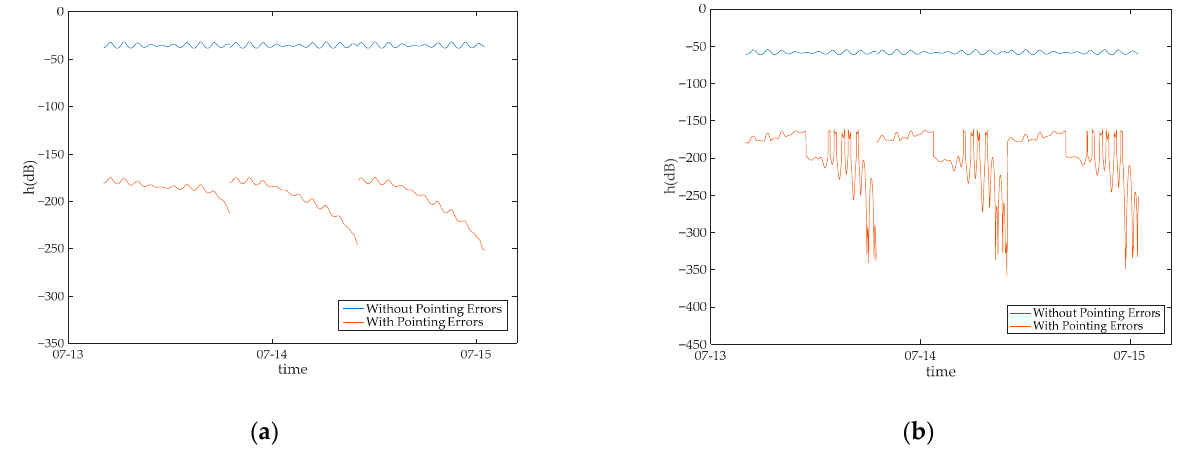
Figure 12. Signal power attenuation with no pointing error and with pointing error: ( a ) uplink terahertz communication link for LEO-GEO; ( b ) downlink terahertz communication link for GEO-LEO.